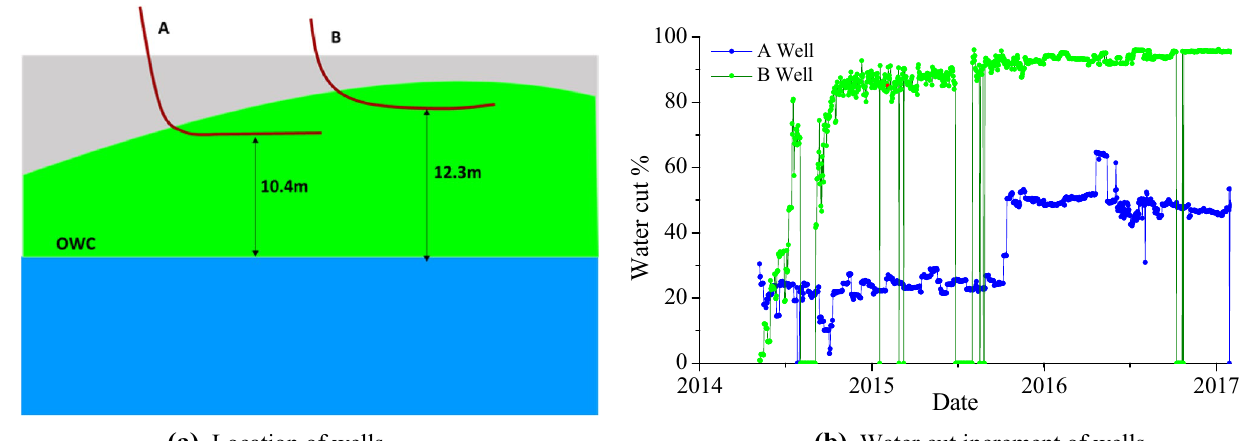
Fig. 9 The cumulative oil pro- duction of four plans